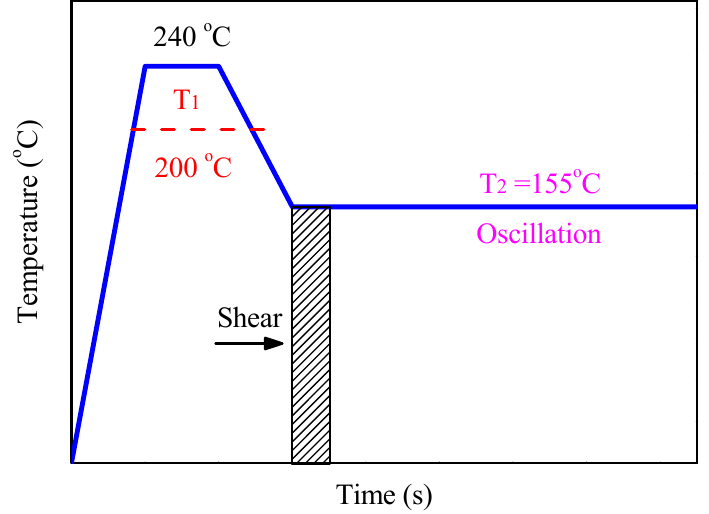
Figure 1. Procedure indications of thermal and shear applications for the rheological measurement of the PLLA/OXA samples.